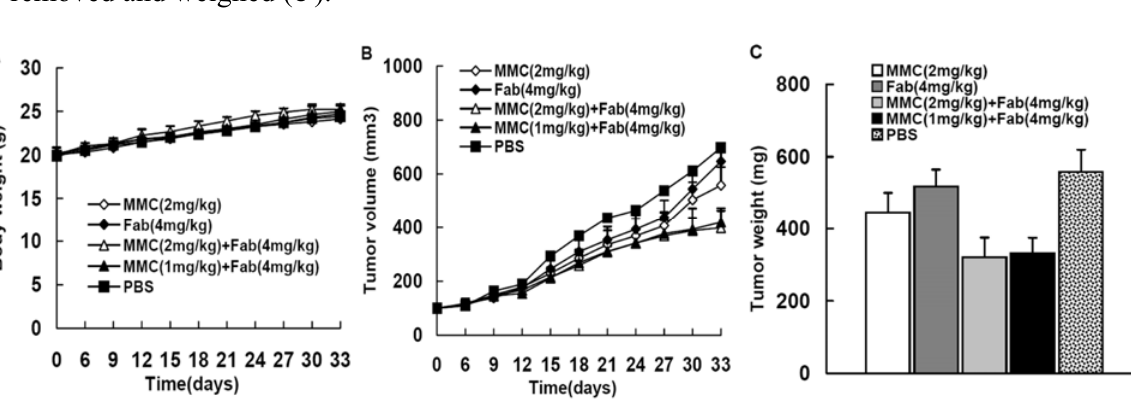
Figure 1. Xenograft nasopharyngeal carcinoma (NPC) tumor growth in five groups. After the inoculation of 5 × 10 6 HNE2 cells/mL, 40 nude mice were randomly divided into 5 groups and treated as indicated. The body weight ( A ) and tumor volume ( B ) were measured at different time points. After 33 days, all mice were sacrificed and tumors were removed and weighed ( C